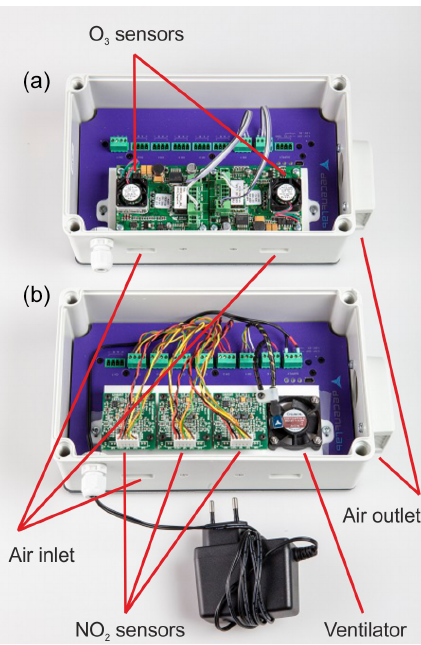
Figure 1. Interior view of the engineered sensor unit: (a) box 1, (b) box